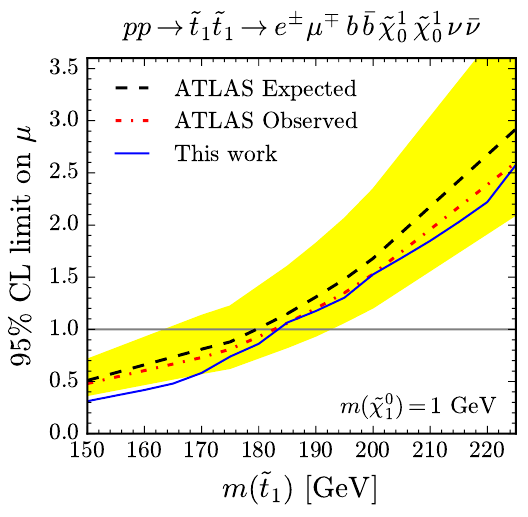
Figure 7 . Our recast of the ATLAS result [16, 60] of the signal strength (cid:22) vs. the stop mass; our result matches the observed limit over most of the parameter space. As the stop mass drops below 180 GeV, three-body e(cid:11)ects and spin correlations start to impact the b -tagging e(cid:14)ciency, and our limit drops to the lower range of the expected uncertainty band as discussed in the